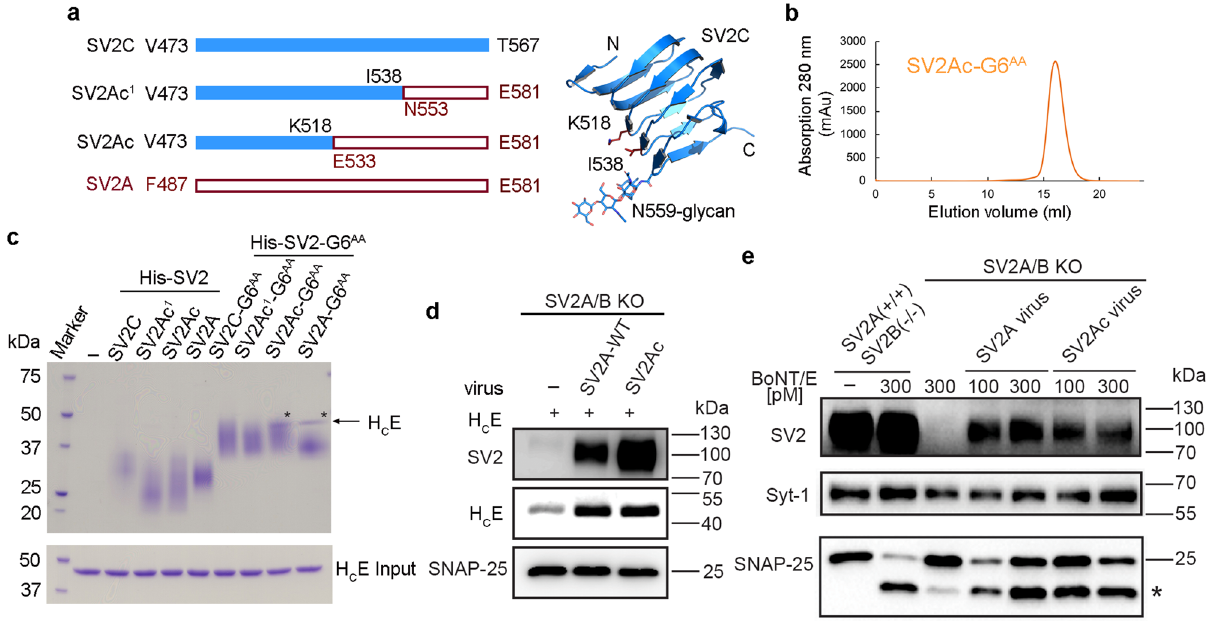
Fig. 2 | An engineered SV2A – SV2C chimera maintains an SV2A-like binding to result is shown ( n =3). d and e The full-length SV2A and SV2Ac were expressed via BoNT/E. a A schematic diagram showing the designs of SV2A – SV2C chimeras lentiviral transduction in mouse cortical neurons cultured from SV2A/B double where the sequences of SV2C-L4 and SV2A-L4 are shown as blue and red hollow knockout (KO) mice. Neurons were exposed to H C E (5min) ( d ) or BoNT/E at the indicated concentration (24h in medium) ( e ). Cell lysates were harvested and bars, respectively. The structure of SV2C-L4 is shown as a blue cartoon with resi- analyzed by immunoblot assays. The synaptic vesicle protein, Synaptotagmin 1 dues K518, I538, N559, and the N559 glycan shown as sticks (PDB: 5JLV. b The chi- (Syt-1), was detected as a loading control. The SNAP-25 antibody can detect both meric SV2Ac – G6 AA fusion protein is mono-dispersed in solution based on a gel- fi ltrationanalysis. c Apull-downassaywasperformedusingH the full-length SNAP-25 and the fragment generated after cleavage by BoNT/E C EaspreyandtheHis- tagged SV2-L4 or SV2 – G6 AA fusion proteins as baits. Only SV2A – G6 AA and (marked with *). SV2A(+/+)/SV2B( − / − ) neurons were analyzed in parallel as a posi- SV2Ac – G6 AA were able to pull down H C E (indicated by asterisks), but not other tive control. A representative result is shown ( n =2). Source data are provided as a SV2 – G6 AA fusion proteins or the stand-alone SV2-L4 variants. A representative Source Data fi